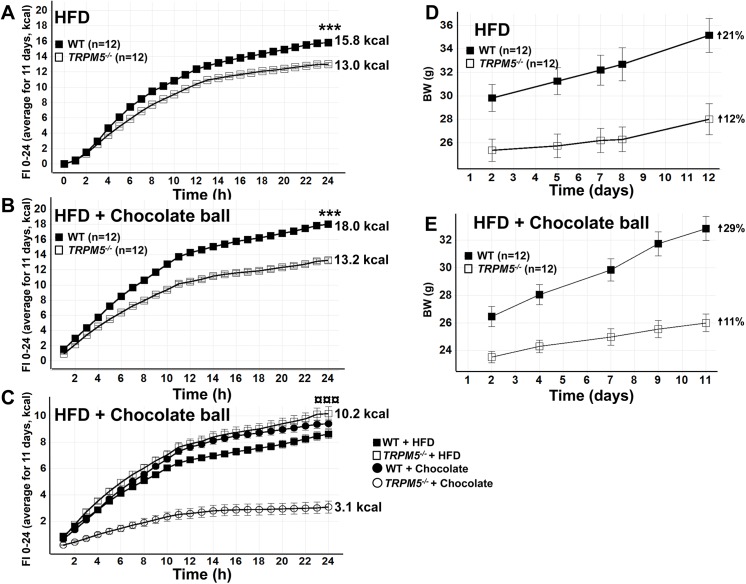
Effects of diets on caloric intake and preference of respective diet in female Trpm5
-/- and wild type mice.Total caloric intake of HFD alone (A), of HFD and a chocolate ball when offered together (B) and of HFD and chocolate ball respectively when offered together (C). Body weight gain when offered HFD alone (D) or when offered HFD and a chocolate ball together (E). Data are presented as mean ± SEM, ***p<0.001, total caloric intake Trpm5
-/- vs wild type mice, ¤¤¤ p<0.001 caloric intake from HFD vs chocolate ball for Trpm5
-/- mice (Students t-test).